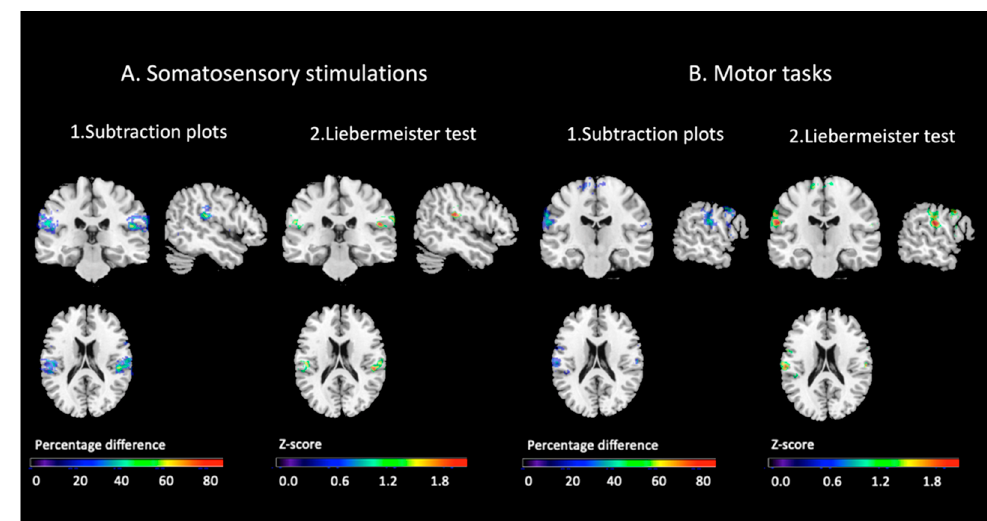
Figure 4. Comparison of the distribution of the conjunction effects for all somatosensory conditions and all motor task conditions. ( A ) Somatosensory task and ( B ) motor task. The Figure shows the subtraction plots between controls and participants with BID in the somatosensory and the motor task (A1 and B1). The percentage overlapping regions of the conjunction of the control group after subtracting the binarized maps of the BID group is illustrated by different colors, coding increasing frequencies from dark blue to red (difference 100%). Only brain regions that were damaged 20% or more frequently in controls than in participants with BID are showed. The figure also shows the result of the Liebermeister test between controls and participants with BID in the somatosensory and motor task (A2 and B2): The color scale illustrates the corresponding Z-score values. Voxels that survived the statistical threshold of p < 0.05 (Z-score = 1.64) uncorrected are shown in red.